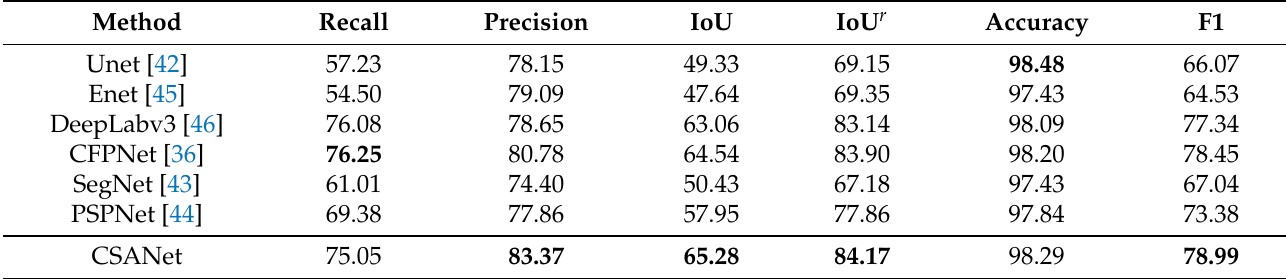
Figure 5. Visualization of segmentation results generated by different methods on the Massachusetts Roads dataset. ( a ) Original image. ( b ) Ground truth. ( c ) CSANet. ( d ) Deeplabv3. ( e ) UNet. ( f ) ENet. ( g ) CFPNet. ( h ) SegNet. ( i ) PSPNet. Table 2. Qualitative comparison of the proposed method (CSANet) with other methods on the DeepGlobe